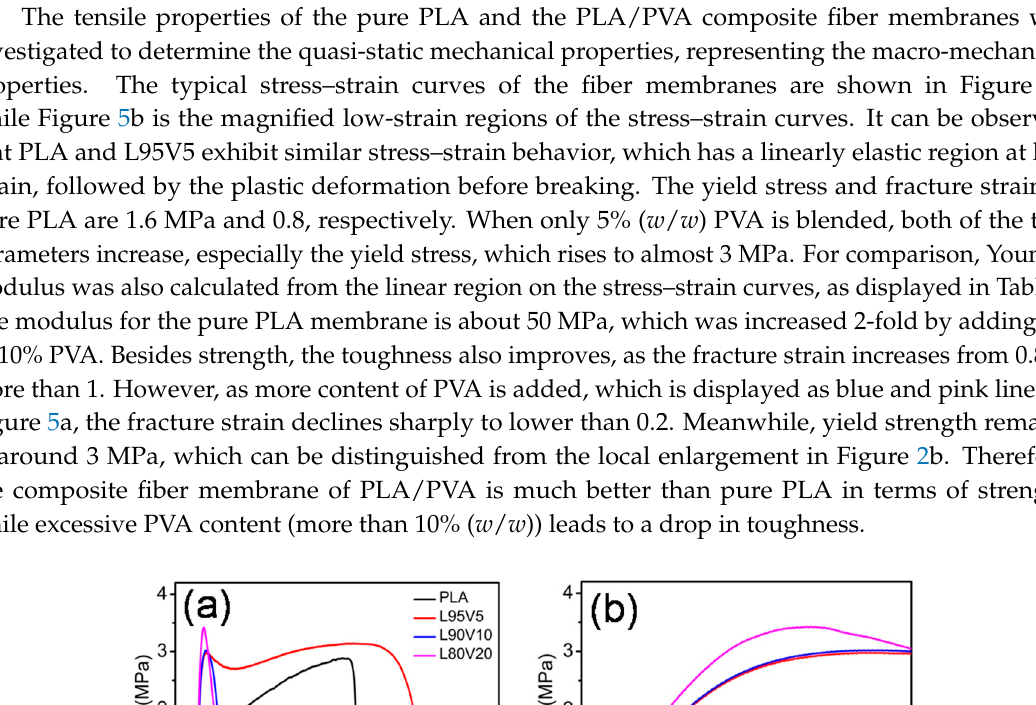
Figure 4. Fourier transform infrared (FTIR) spectra of the pure PLA and PLA/PVA composites in the spectral range of ( a ) 950–1250 cm − 1 ; ( b ) 900–980 cm − 1 ; and ( c ) 1750–3600 cm − 1 .